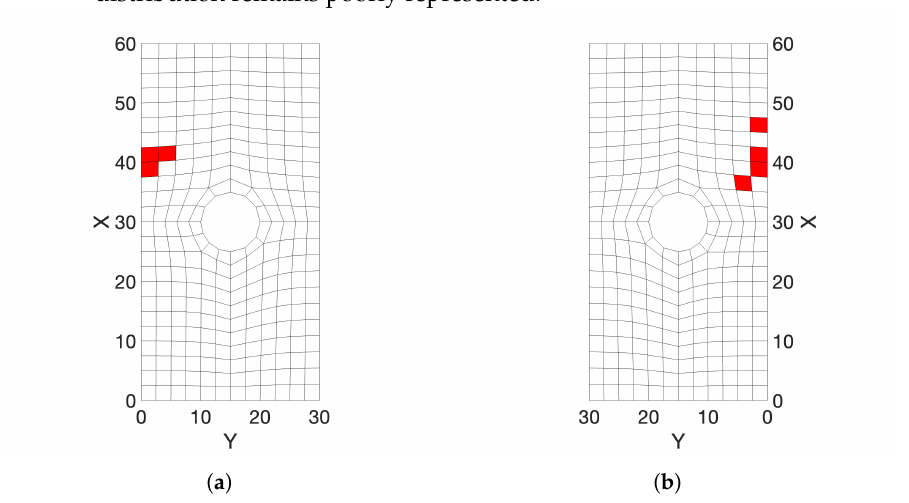
Figure 10. Identified elements affected by the damage (in red) at the first iteration ( q = 1) of the algorithm proposed in Section 3.1. ( a ) Top view; ( b ) bottom